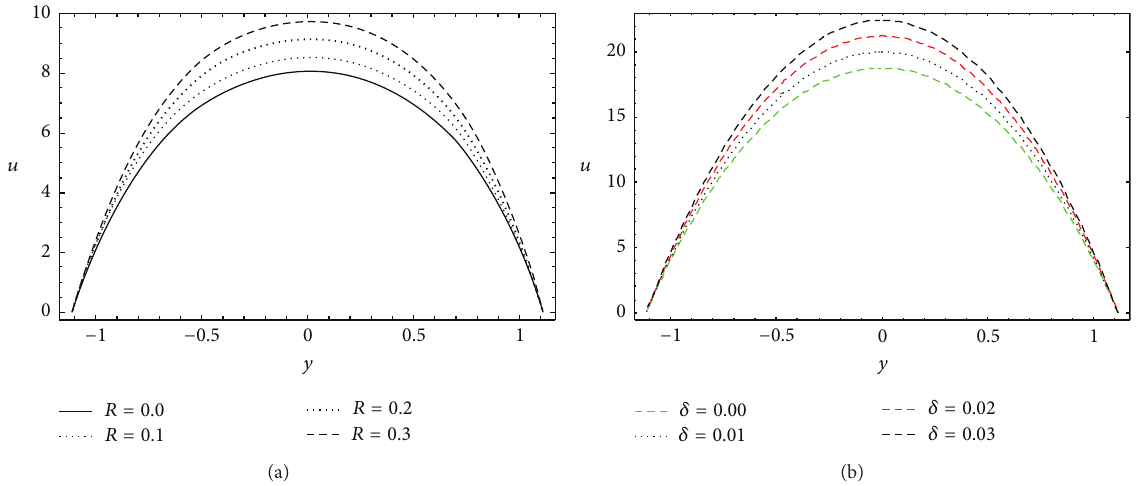
Figure 2: Variation on 𝑢 when 𝐸 1 = 1 , 𝐸 2 = 0.2 , 𝐸 3 = 0.5 , 𝜀 = 0.2 , 𝛽 = 0.05 , 𝑡 = 0.2 , 𝑀 = 2.5 , 𝜆 1 = 0.1 , 𝜆 2 = 0.0 , and 𝑥 = 0.3 plotted for (a) for different values of 𝑅 and (b) different values of 𝛿 .